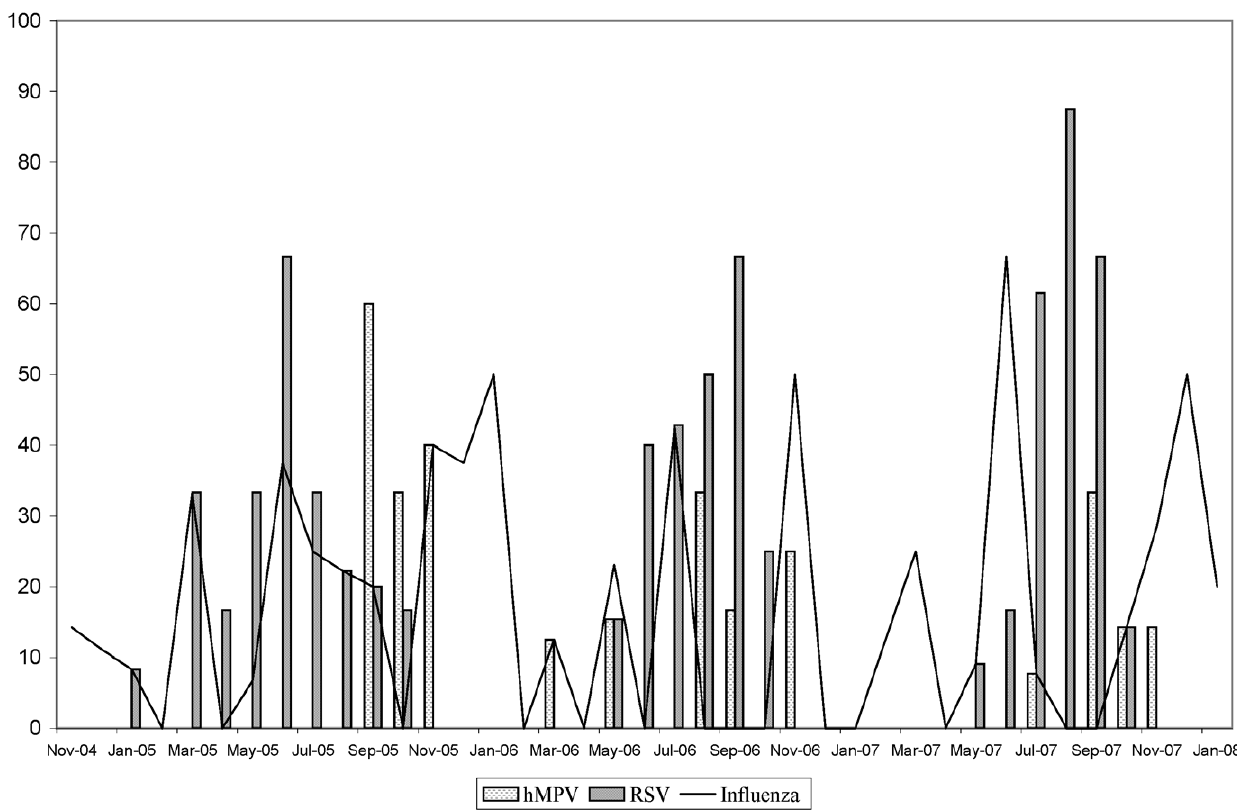
Figure 1. Proportion of RSV and hMPV positive cases recruited each month from November 2004 to January 2008. Time in months is displayed on the X-axis and the percentage of positive cases of each virus among all cases recruited in that month on the y-axis. doi:10.1371/journal.pone.0018176.g001 Table 6. Diagnostic sensitivity and efficacy of respiratory specimens and combined nasal-throat (NT) swabs by viral etiology.